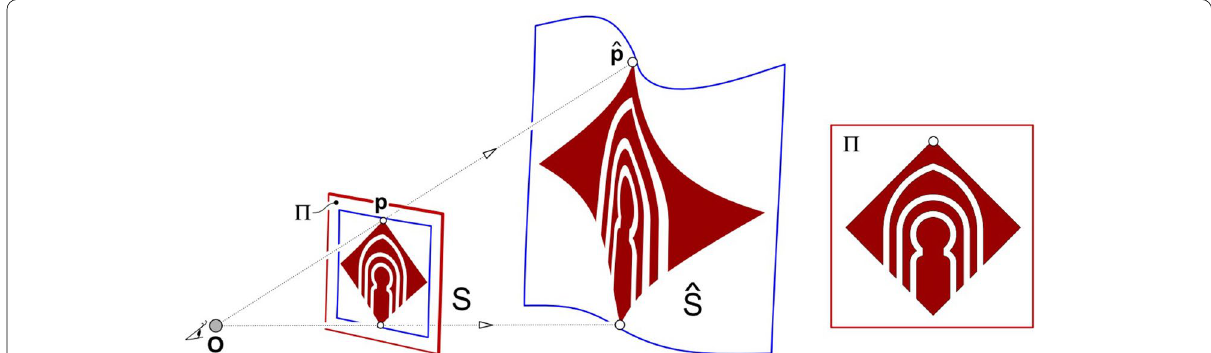
Fig. 27 Sánchez‑Reyes and Chacón [69] used rational B´ezier surfaces or volumes to create